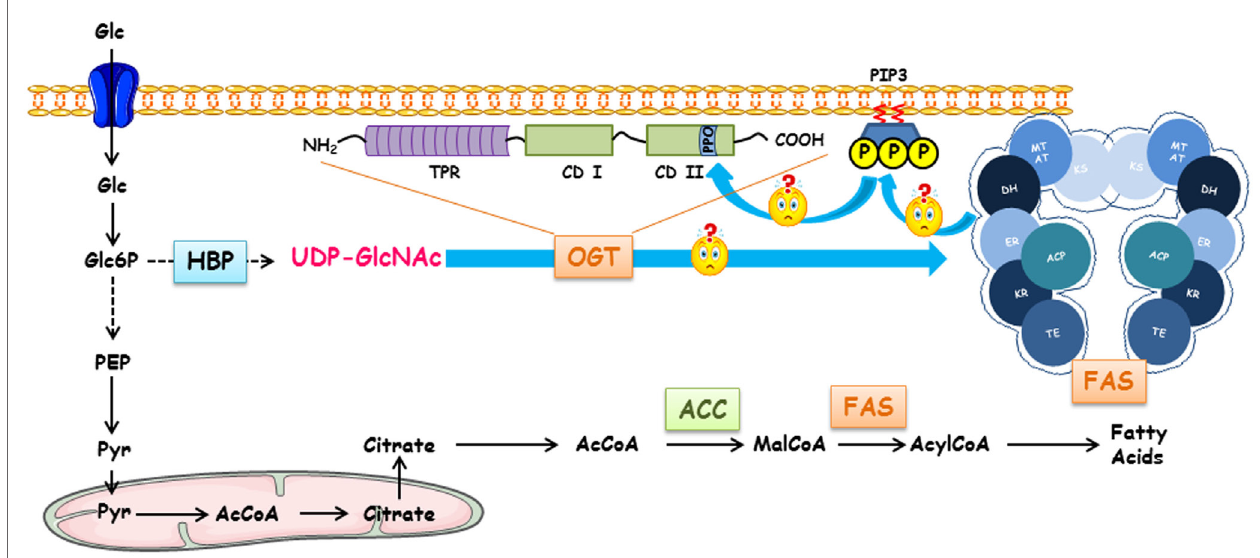
FiGUre 1 | regulation of fatty acid synthase by O -GlcNAcylation, Terra incognita . FAS expression and O -GlcNAcylation levels are dependent on glucose concentrations. Following its entry into the cell, glucose can engage in different metabolic pathways depending on the cell type and the physiological context (glycolysis, glycogenogenesis, pentose phosphate pathway, etc.). HBP converts a fraction of glucose into UDP-GlcNAc, the donor for O -GlcNAcylation processes. Either for storing energy or for the biosynthesis of membranes of proliferating cells, a large pool of glucose can be used for making fatty acids of which FAS (fatty acid synthase) is a key enzyme. FAS forms a head-to-head X-shaped homodimer. Each 273 kDa-subunit of FAS is an assembly line of fatty acids endowed with seven different catalytic activities. First, the acetyl moiety provided by acetyl-CoA is transferred to the thiol group of the phosphopantetheine part of ACP (acyl